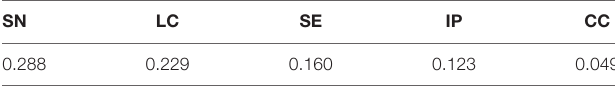
TABLE 2 | Q-squared coefficients. TABLE 3 | Model fit and quality indices.